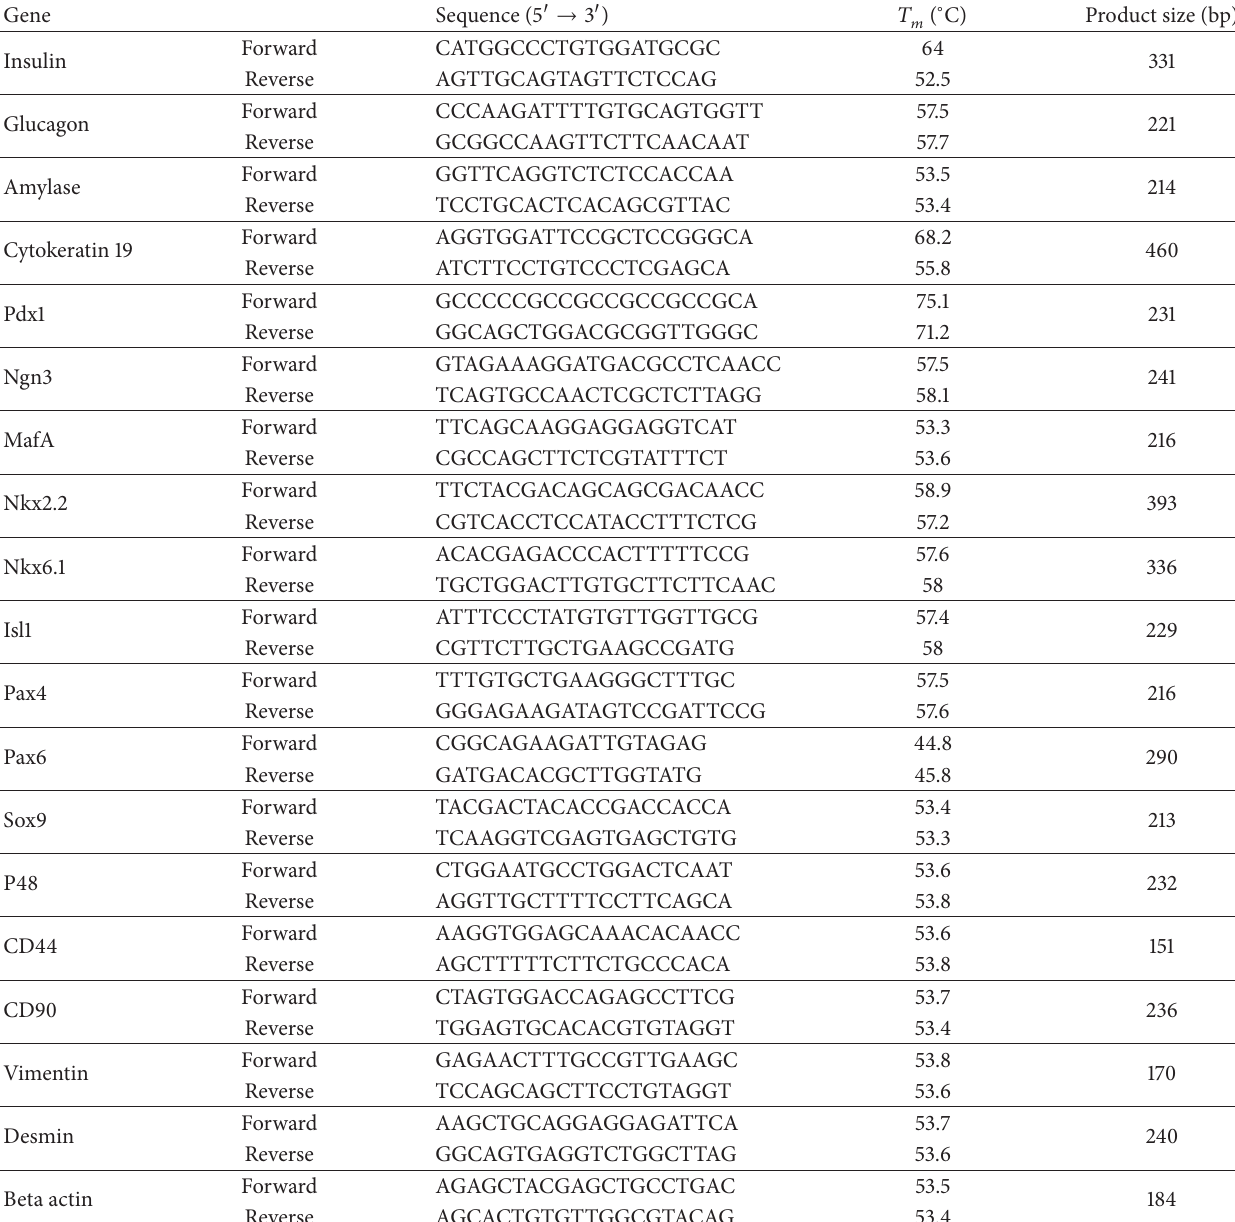
Table 1: Primers used for PCR